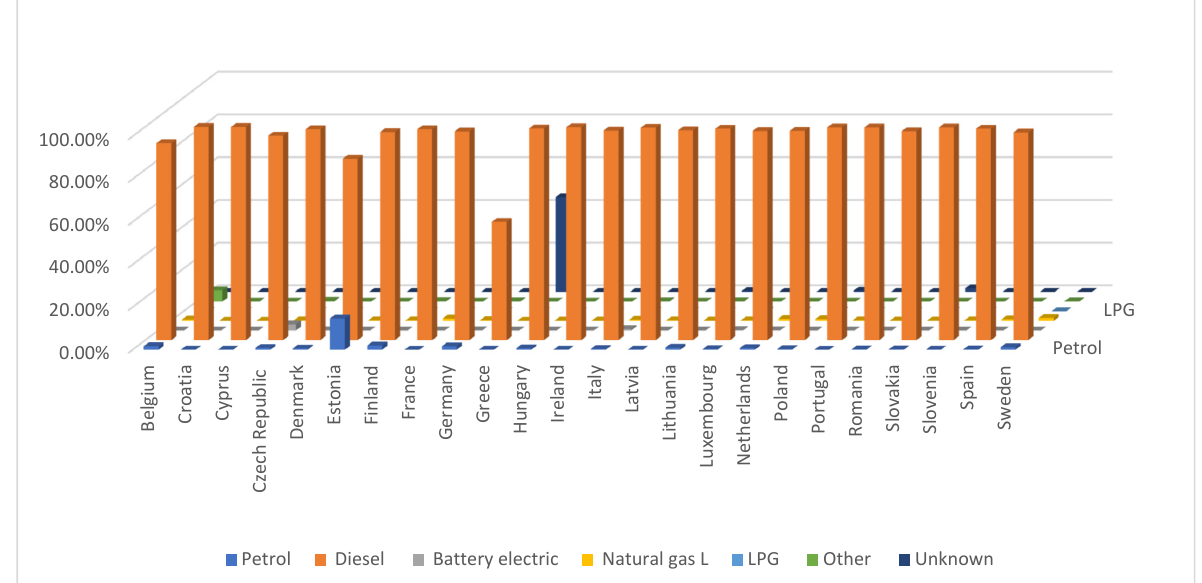
Figure 1. Medium and heavy commercial vehicles by fuel type in EU in 2020 [30]. (no data from some UE countries).